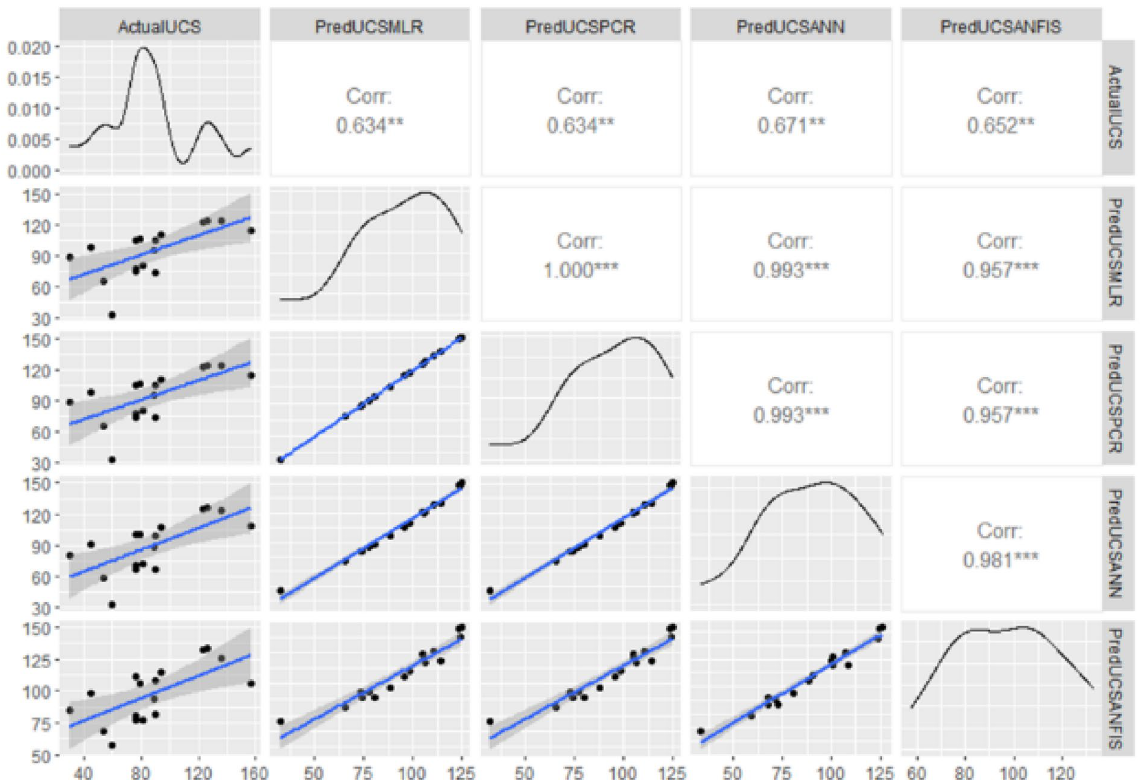
Figure 10. Estimated regression models for the three techniques.